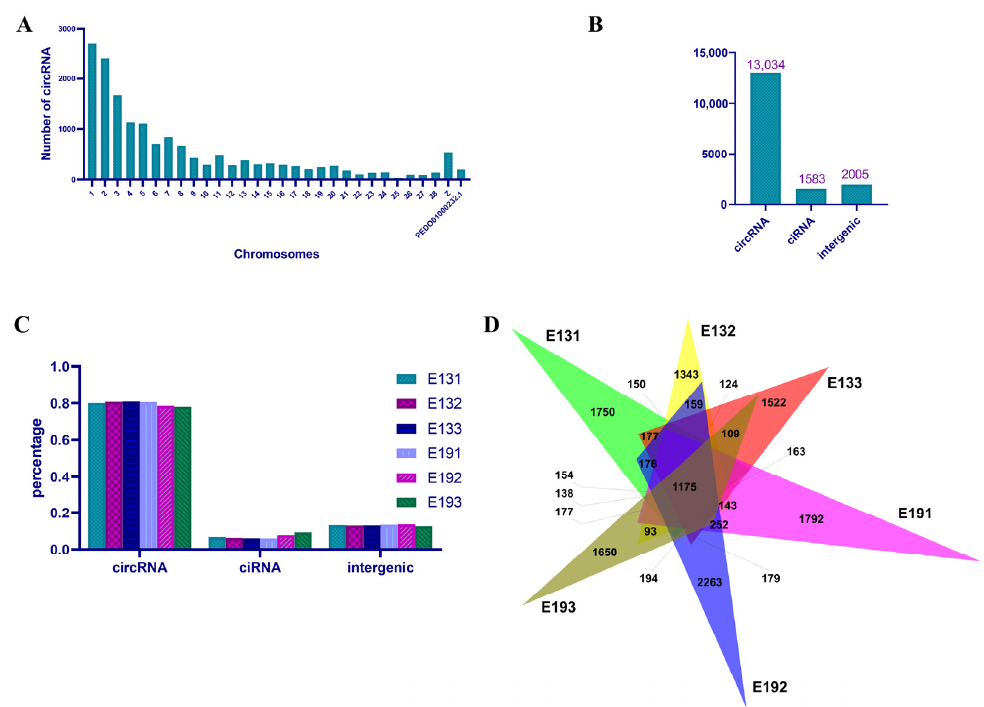
Figure 1. Circular RNA expression profiling. ( A ) Distribution of circular RNAs on duck chromosomes. ( B ) Numbers of different types of circular RNA. ( C ) Percentages of different types of circular RNA in each sample. circRNA, exonic circular RNA; ciRNA, intronic circular RNA; intergenic, circular RNA generated from intergenic sequence. ( D ) Venn diagrams of circular RNAs expressed in each sample.